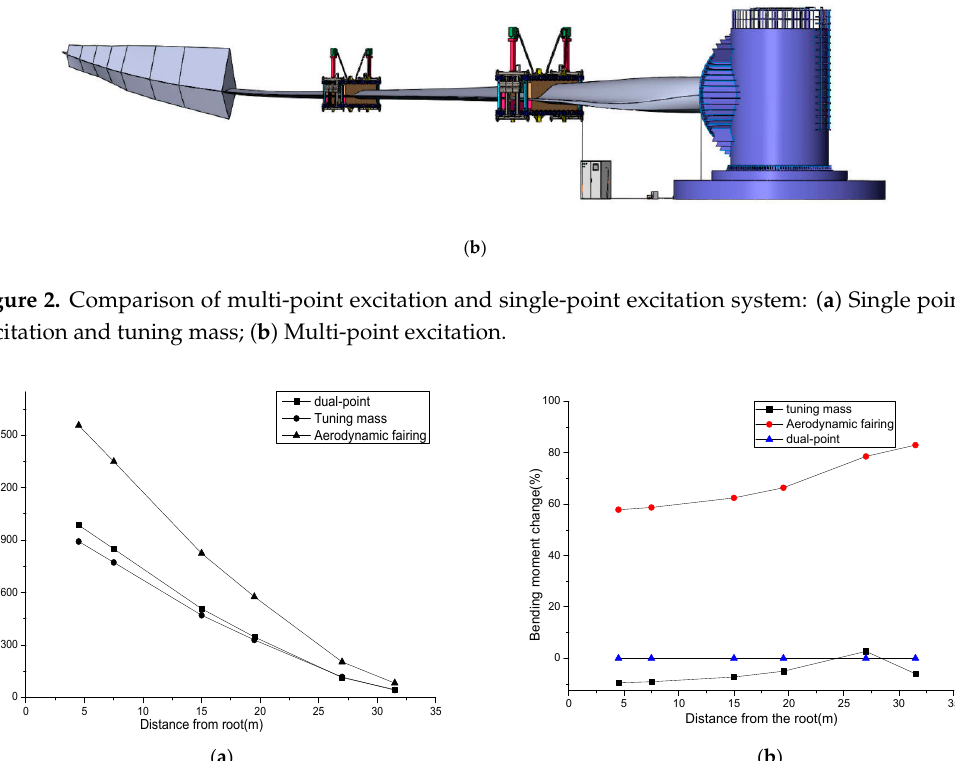
Figure 3. Bending moment distribution for different methods. ( a ) Bending moment distribution for different methods; ( b ) The change of moment distribution for different methods.